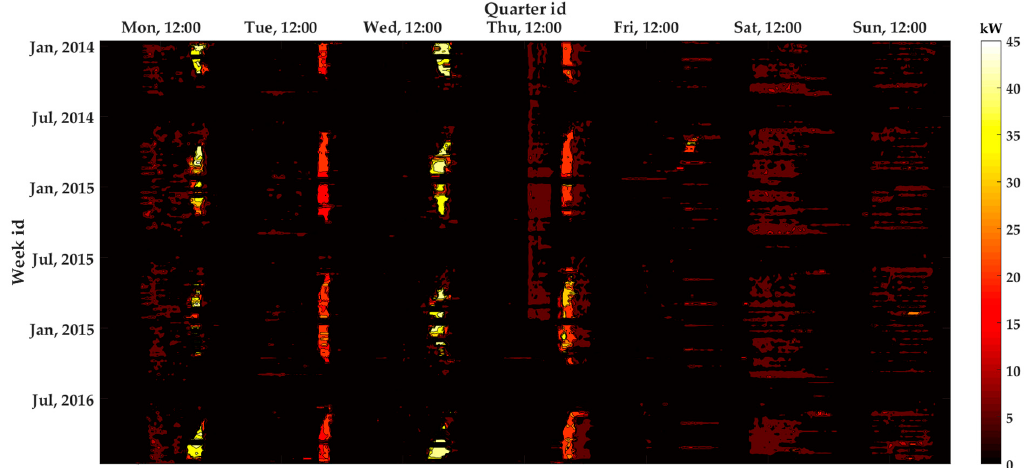
Figure 9. Thermal image—predictable load profile.